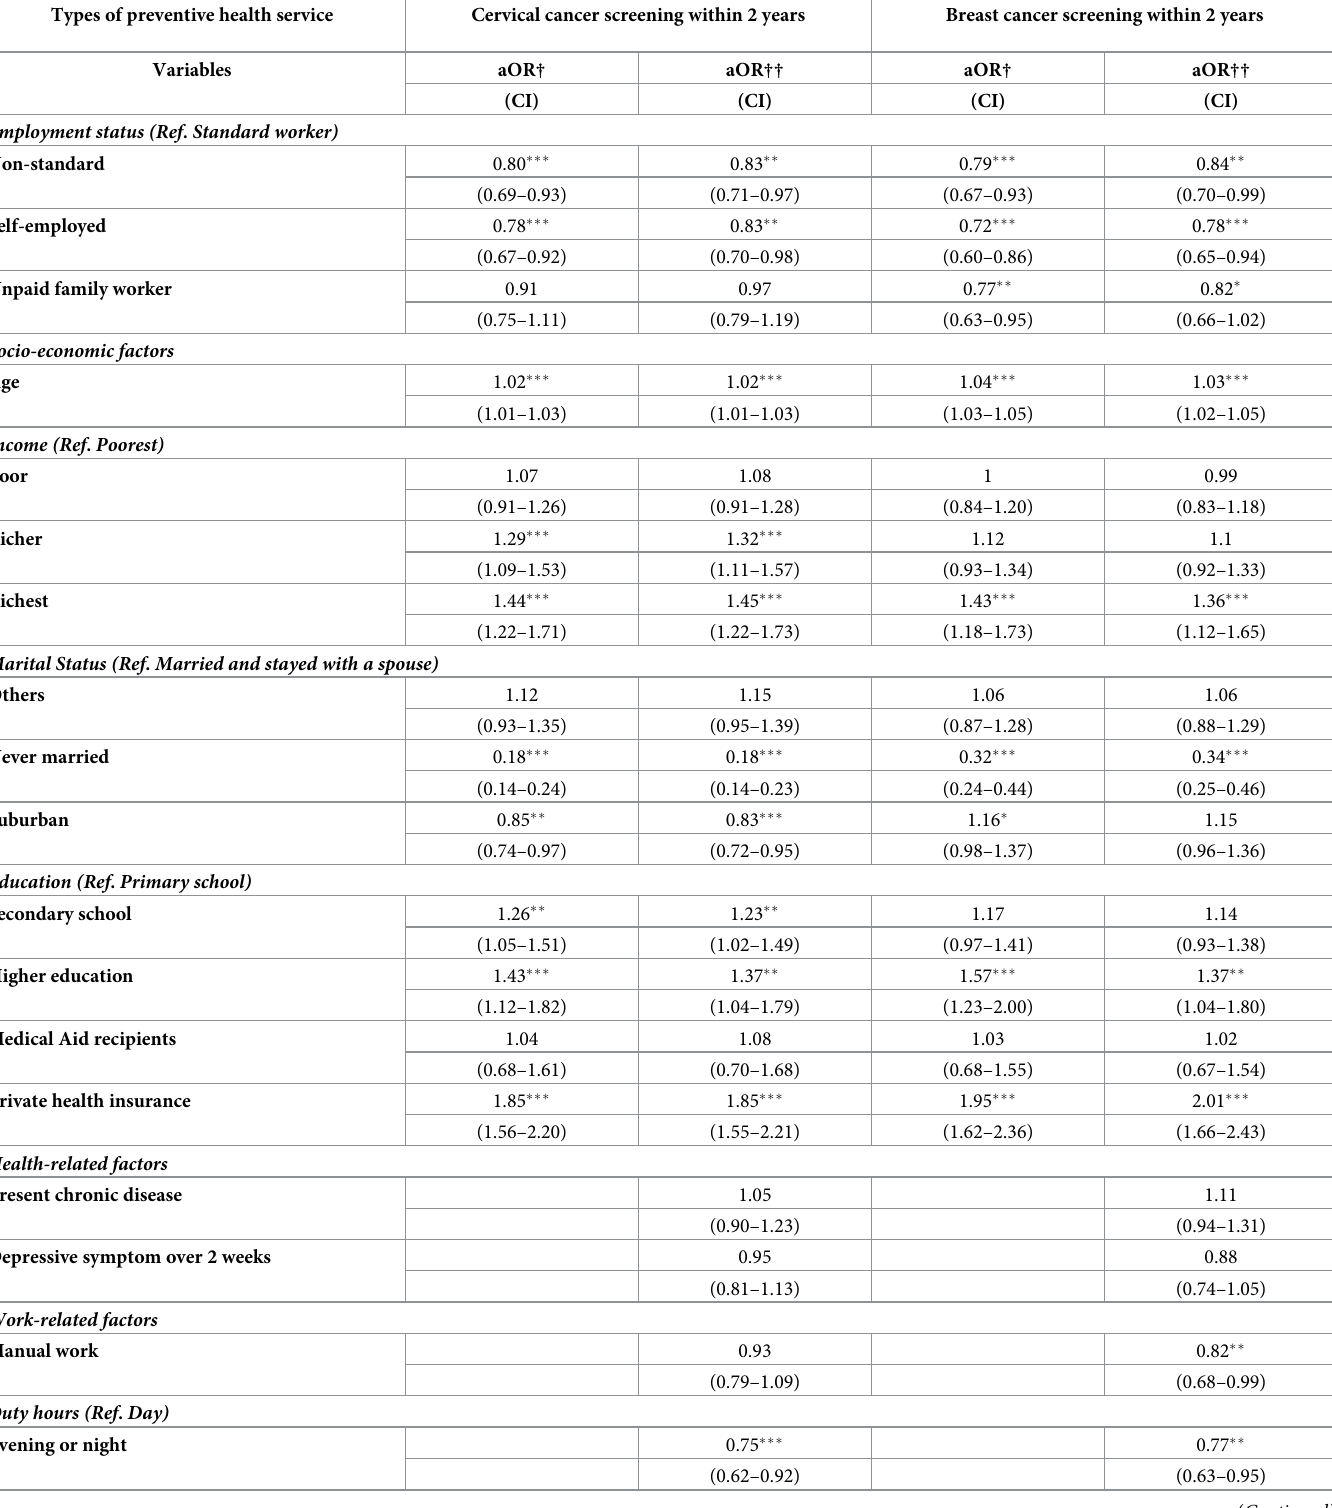
Table 5. Logistic regression analyses of preventive health services for female